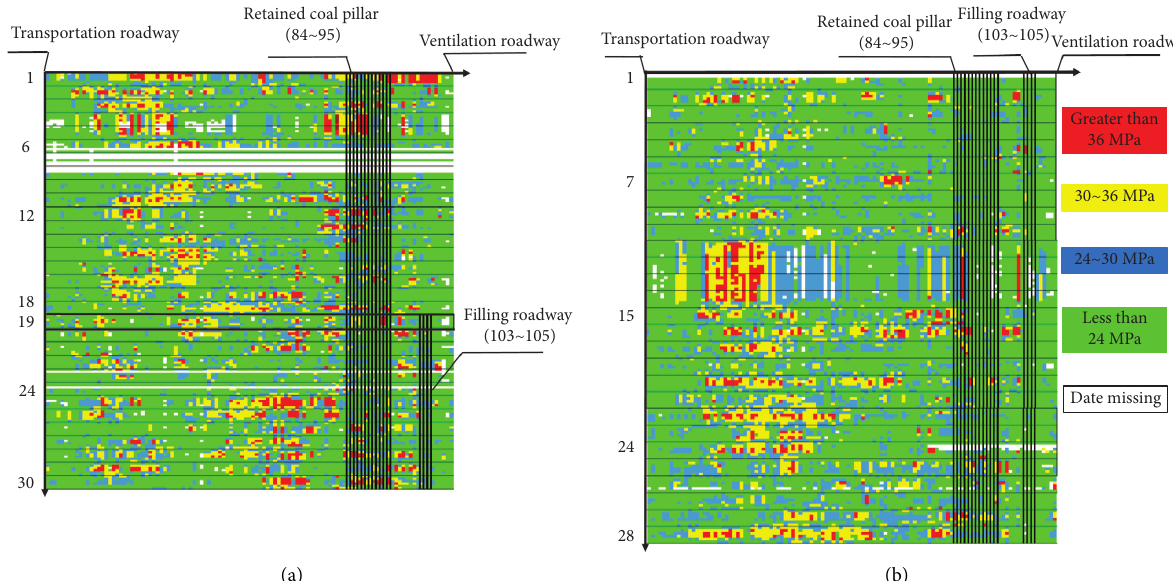
Figure 15: Data from the hydraulic support before and after overfilling the roadway. (a) Data from the hydraulic support in January. (b) Data from the hydraulic support in